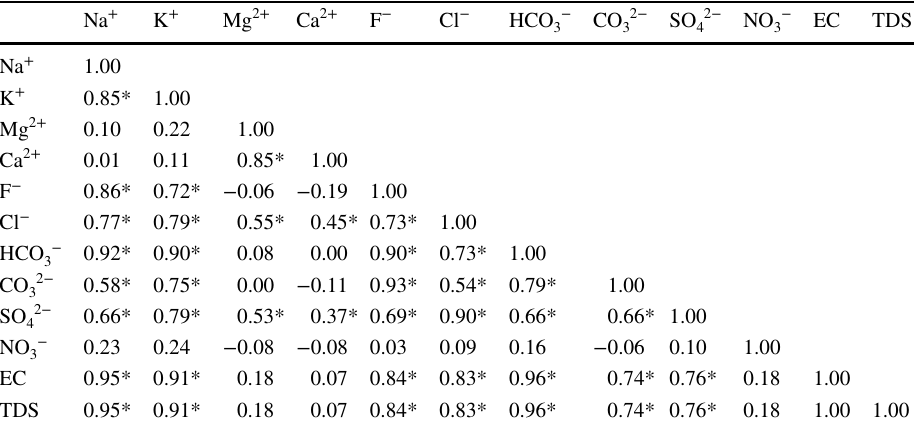
matrix for groundwater samples in Meru district ( N = 54, p = 0.01)